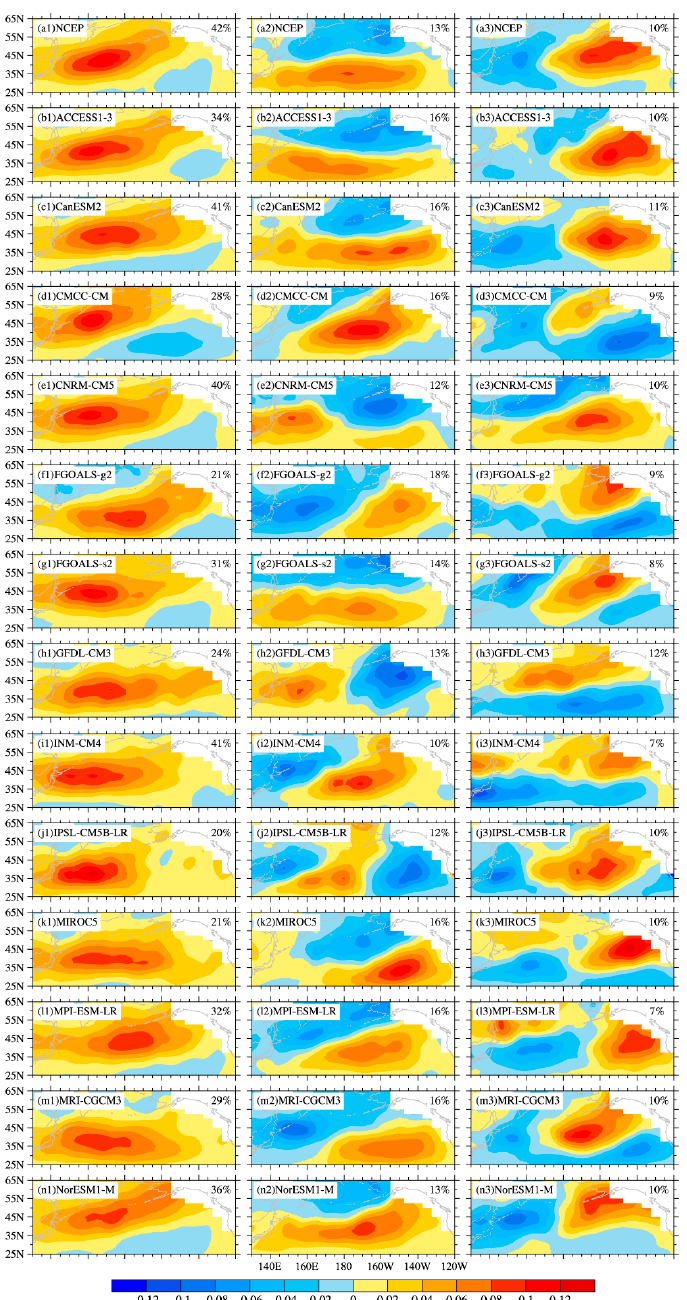
Figure 5. The leading spatial modes of WNPST in reanalysis and CMIP5 models, variance contribution is showed in the upper right corner of each panel.